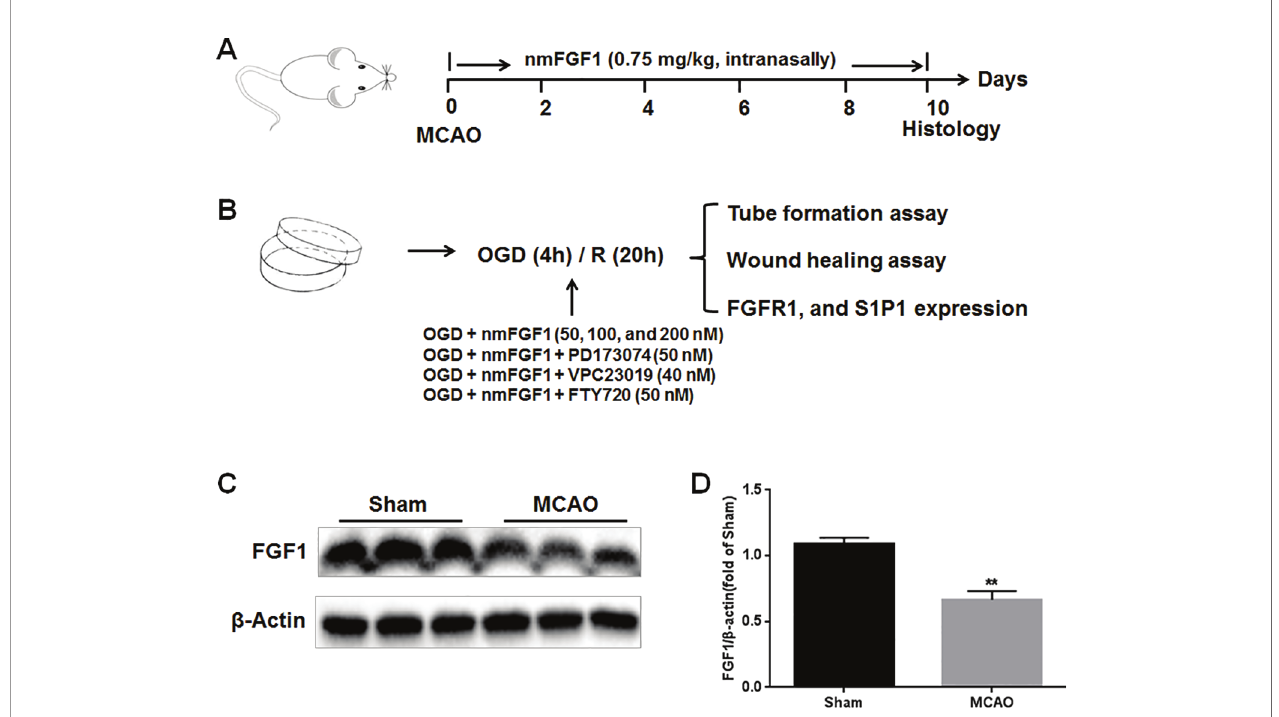
FIGURE 1 | Illustration of experimental procedure. (A) Schematic illustration of animal experimental timeline showing the duration exogenous non-mitogenic fi broblast growth factor 1 (nmFGF1) administration after middle cerebral artery occlusion (MCAO) in adult mice and analysis. (B) Schematic illustration of cell experimental procedure after oxygen-glucose deprivation (OGD)/R and analysis. (C) Representative bands of endogenous FGF1 expression detected by western blot. (D) Densitometric analysis for the protein expression of FGF1. Data are expressed as means ± SEM (n = 5). **p <